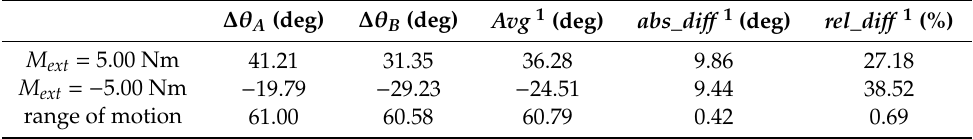
Table 2. Maximal angular displacement ∆ θ i in plantarflexion and dorsiflexion for the two most di ff erent adversarial structures A and B